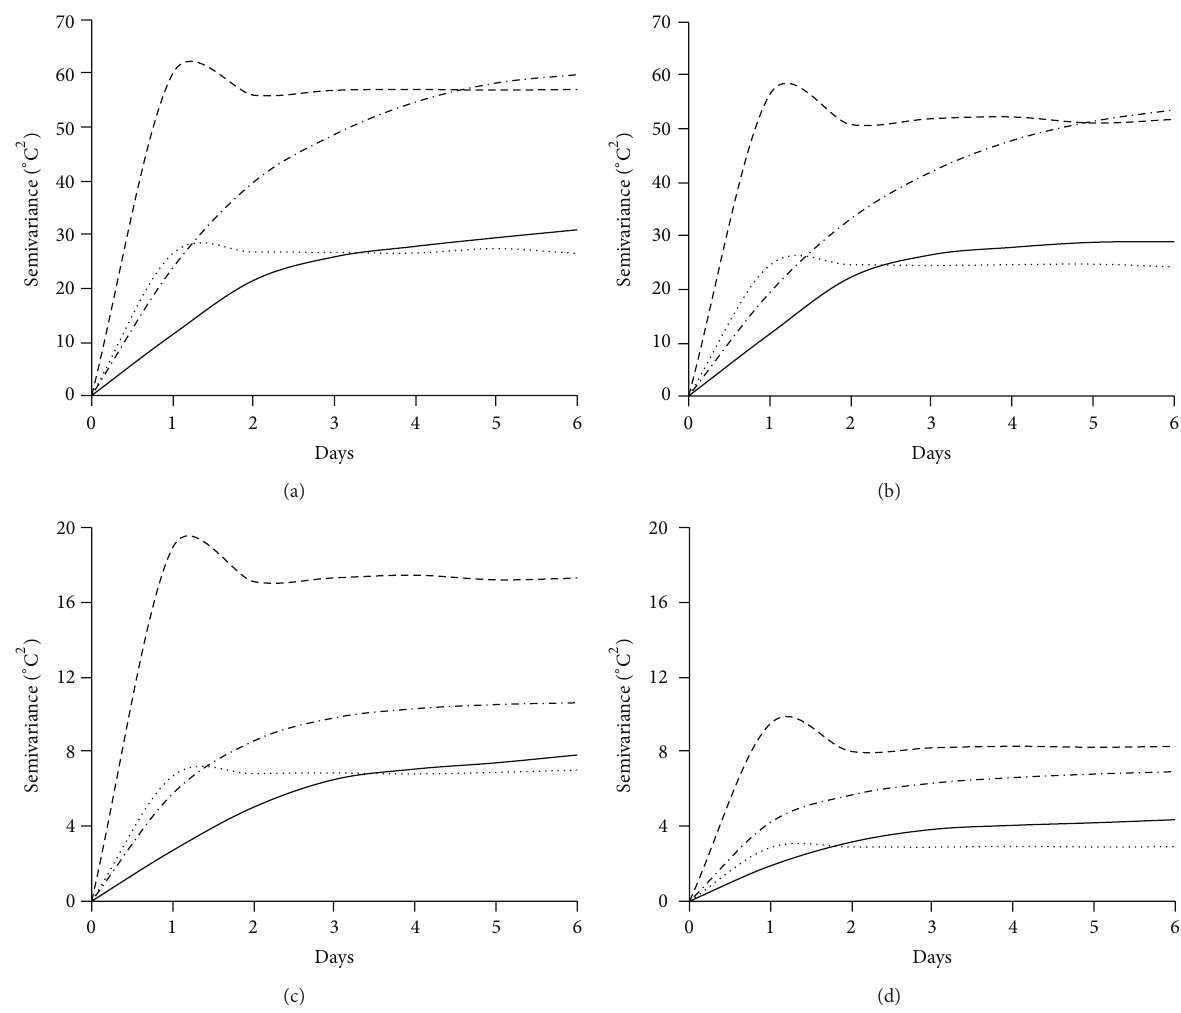
Figure 6: Comparison between observed and generated temporal semivariograms of ((a), (c)) maximum and ((b), (d)) minimum temperatures for the months of January ((a), (b)) and July ((c), (d)). Weather station: Asheboro, Randolph, NC. Observed (solid line), generated by first model (dash line), second model (dots line), and third model (dash and dots